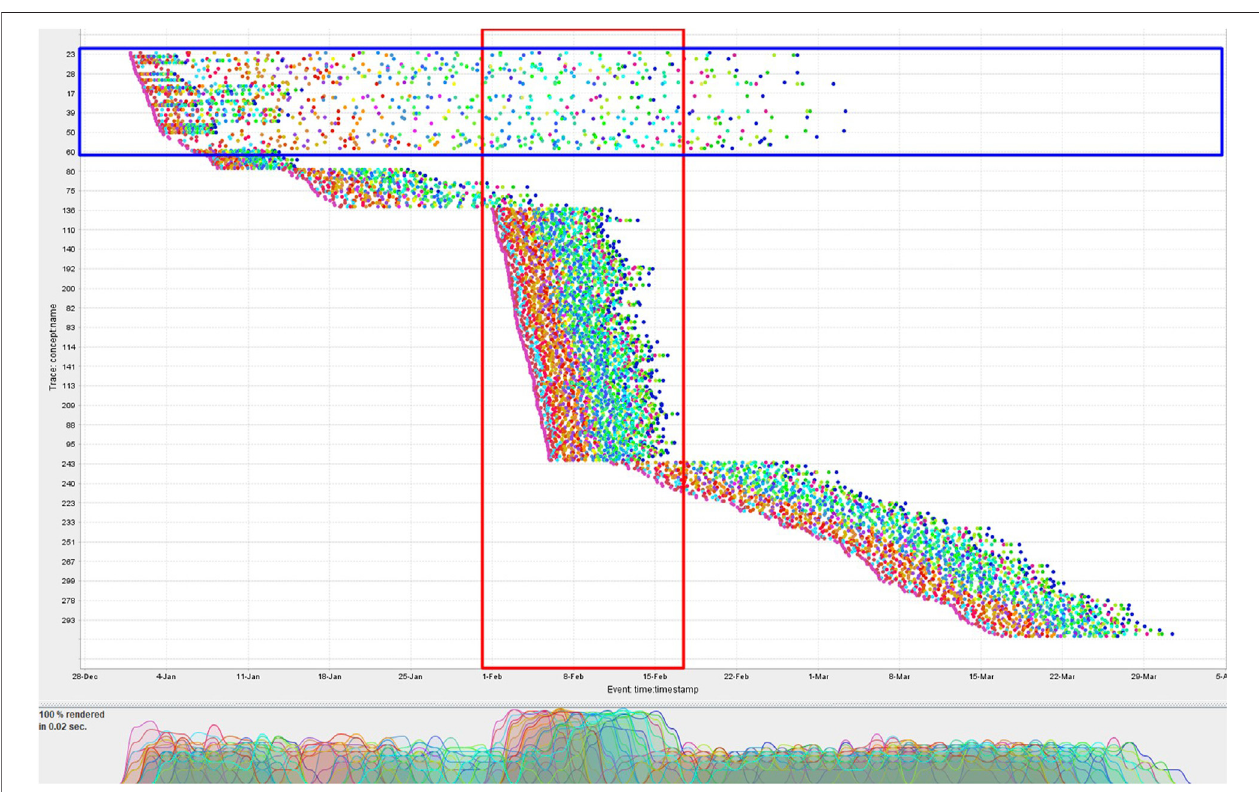
FIGURE 5 | Dotted chart visualization of the CCC ’ 19 event data. Cases are depicted with respect to their actual arrival time. Each point corresponds to an event, and each color corresponds to a distinct class of events. Events for cases are horizontally distributed.